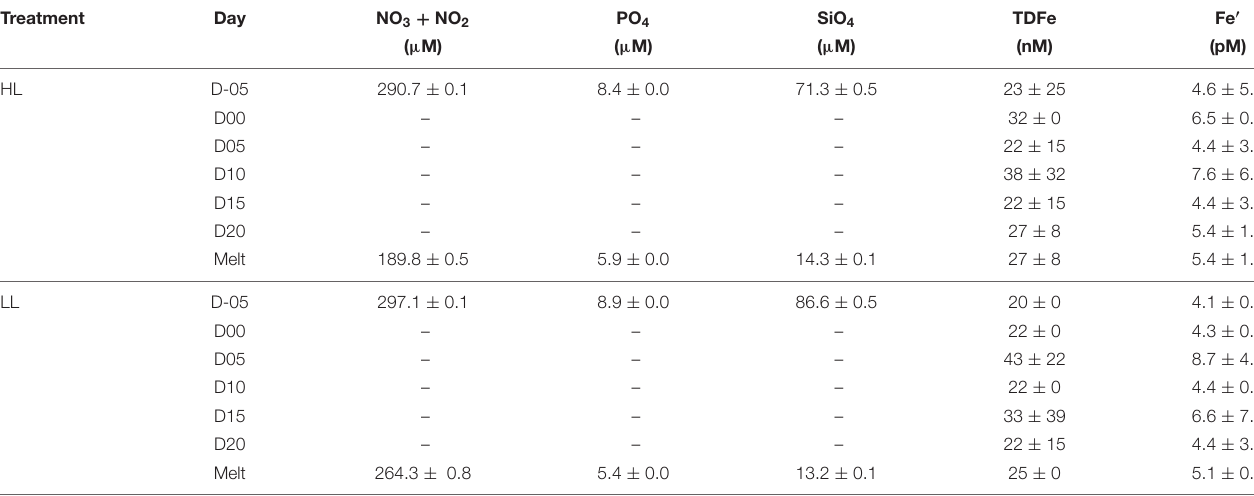
TABLE 2 | Concentrations of macronutrients, total dissolvable Fe (TDFe), and inorganic Fe species (Fe (cid:48) ). Treatment Day NO 3 + NO 2 PO 4 SiO 4 TDFe